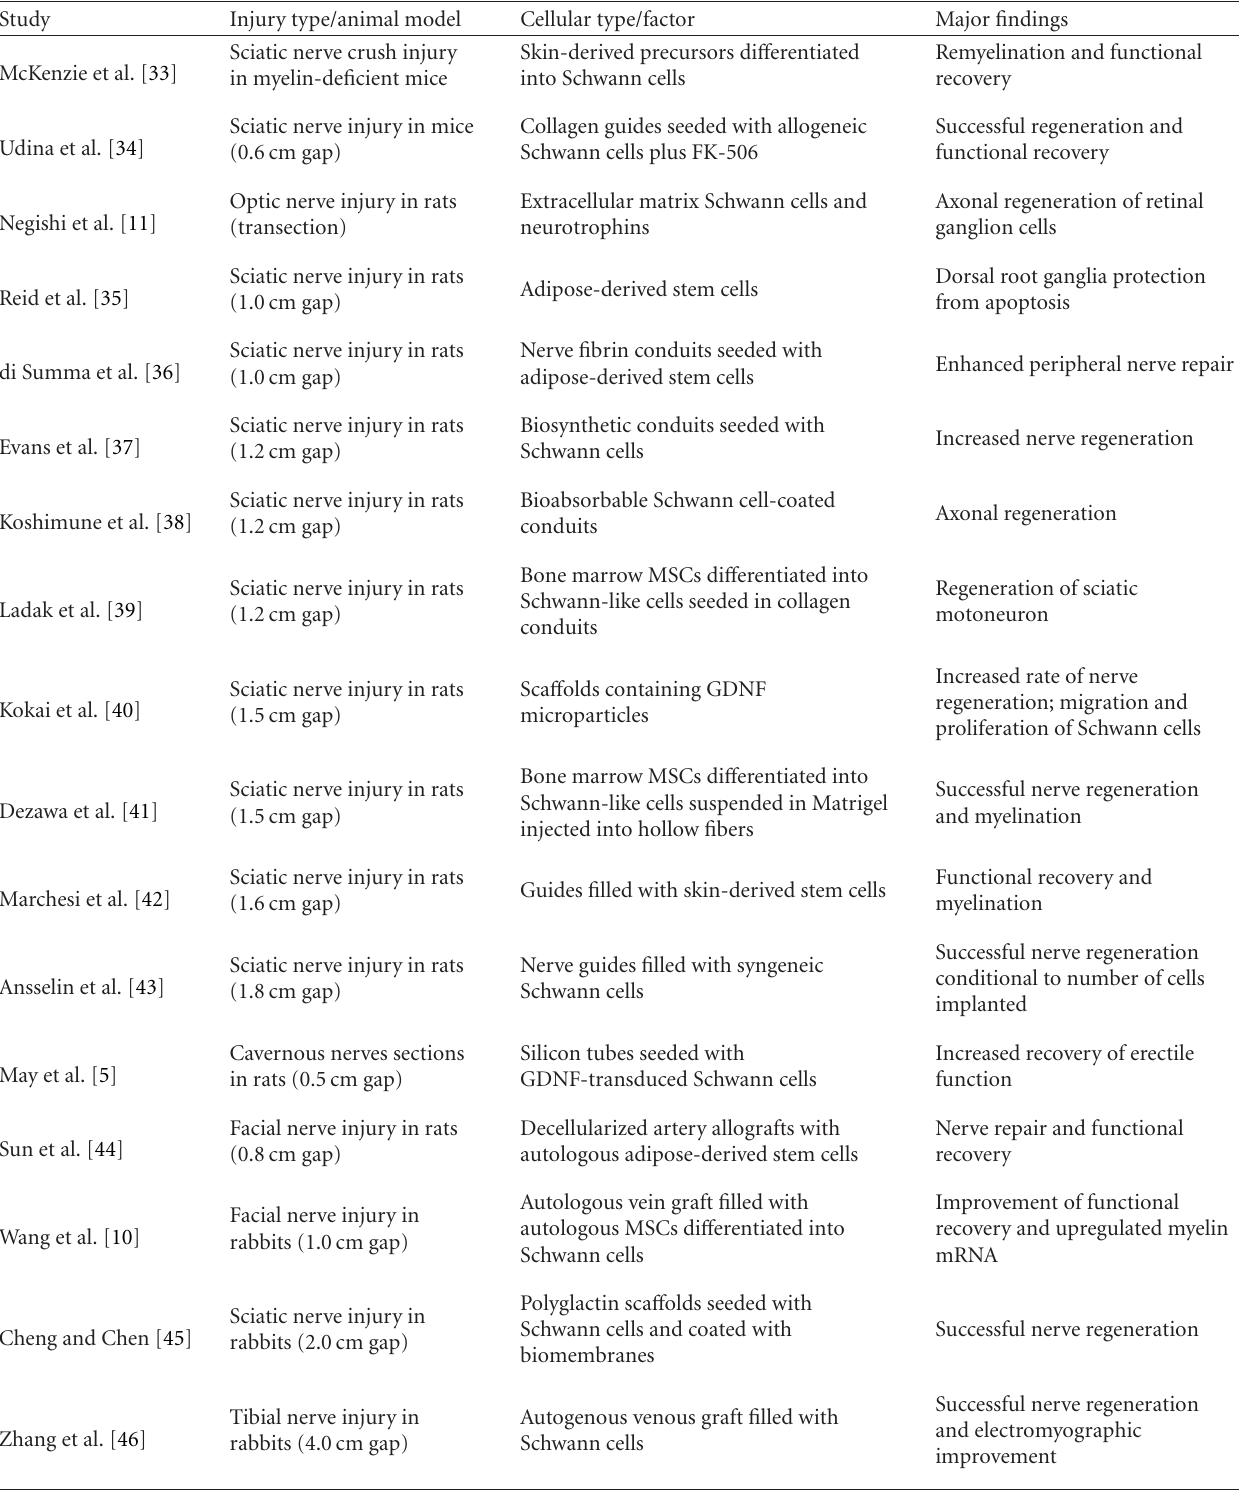
Table 1: Preclinical studies evaluating cell therapy for peripheral nerve repair ∗